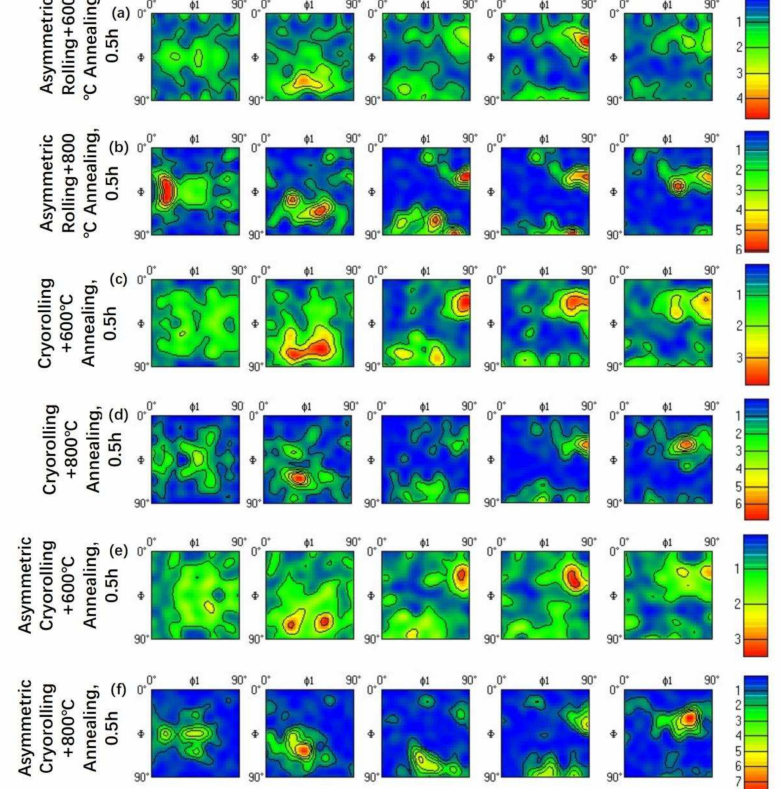
Figure 4. ODFs ( φ 2 = 0 ◦ , 15 ◦ , 35 ◦ , 45 ◦ , and 65 ◦ sections) sections of ( a ) asymmetrically rolled CoCrNi MEA with annealing at 600 ◦ C, ( b ) asymmetrically rolled CoCrNi MEA with annealing at 800 ◦ C, ( c ) cryorolled CoCrNi MEA with annealing at 600 ◦ C, ( d ) cryorolled MEA CrCoNi with annealing at 800 ◦ C, ( e ) asymmetric cryorolled CoCrNi MEA with annealing at 600 ◦ C, and ( f ) asymmetric cryorolled CoCrNi MEA with annealing at 800 ◦